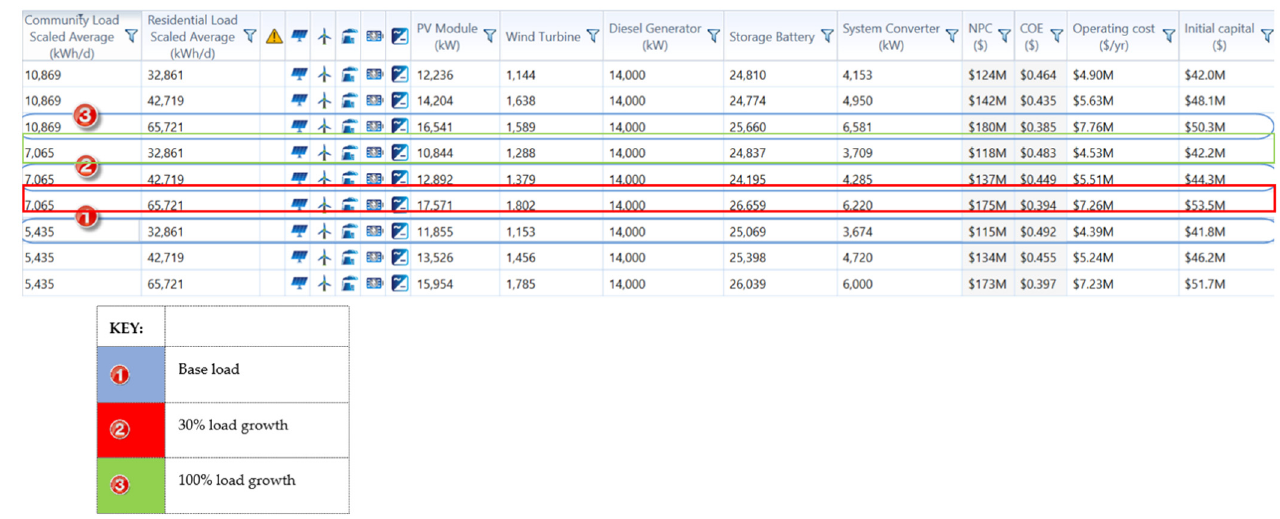
Figure 17. Impact of load growth on system costs.